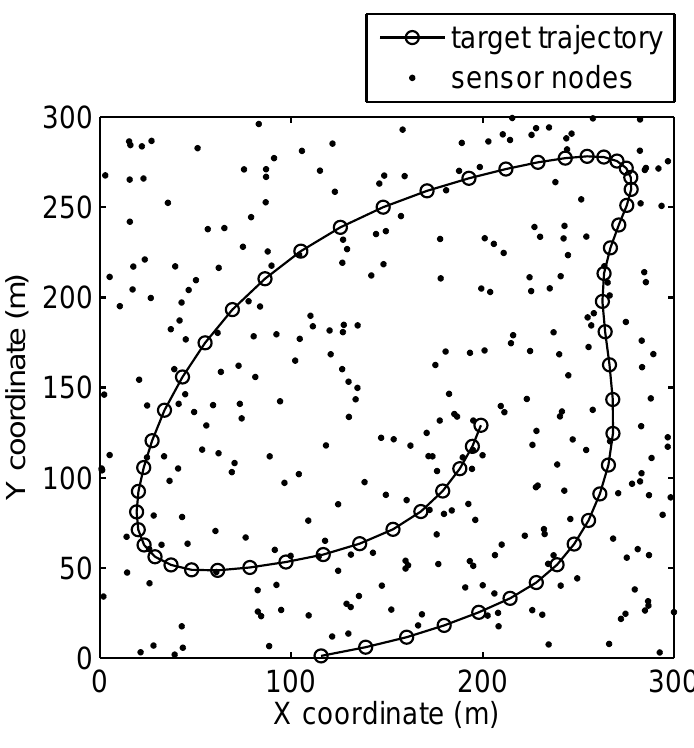
Figure 6 . Sensor node deployment and tracked vehicle